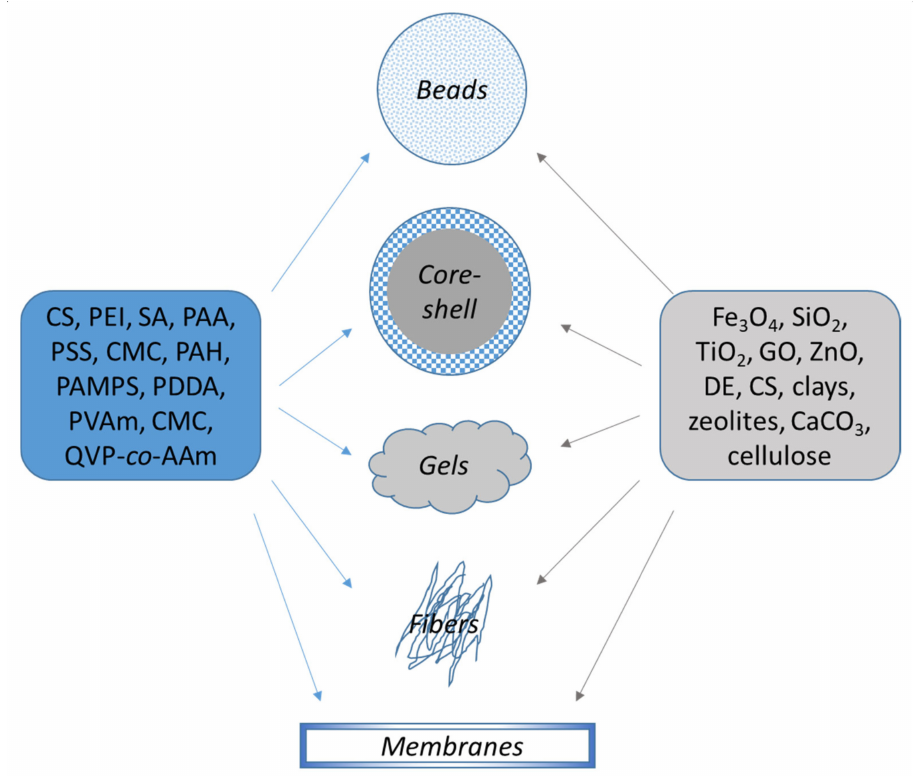
Figure 3. Organic/inorganic composite sorbents based on